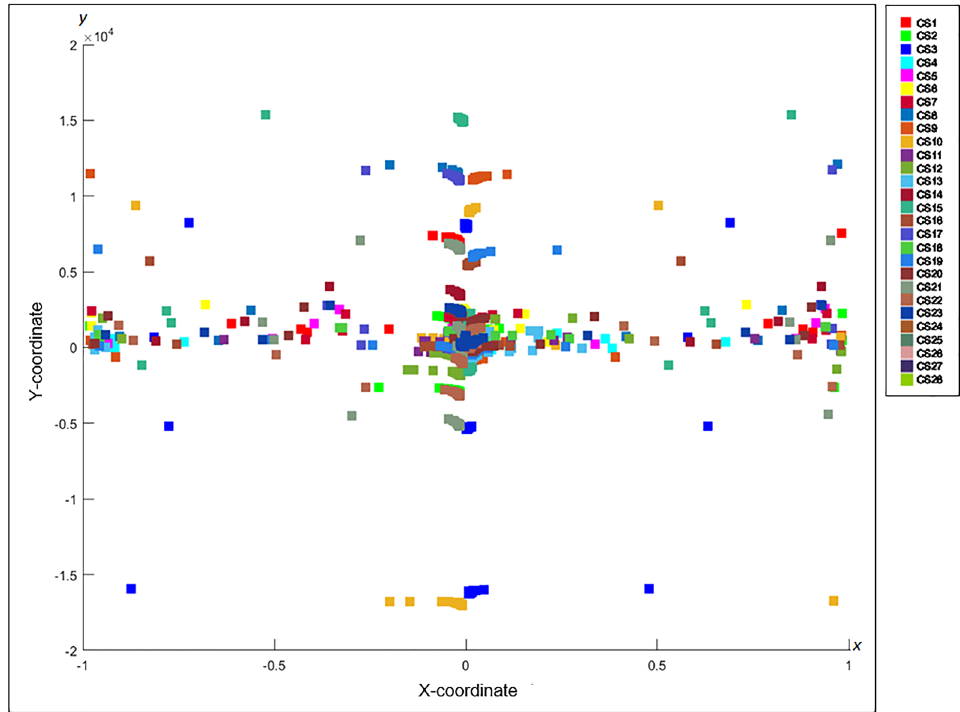
Figure 12. Coordinated FACS of Counterfeit RM50. This figure was generated using MATLAB version R2016a (Mathworks, Natick, MA; https:// www. mathw orks.